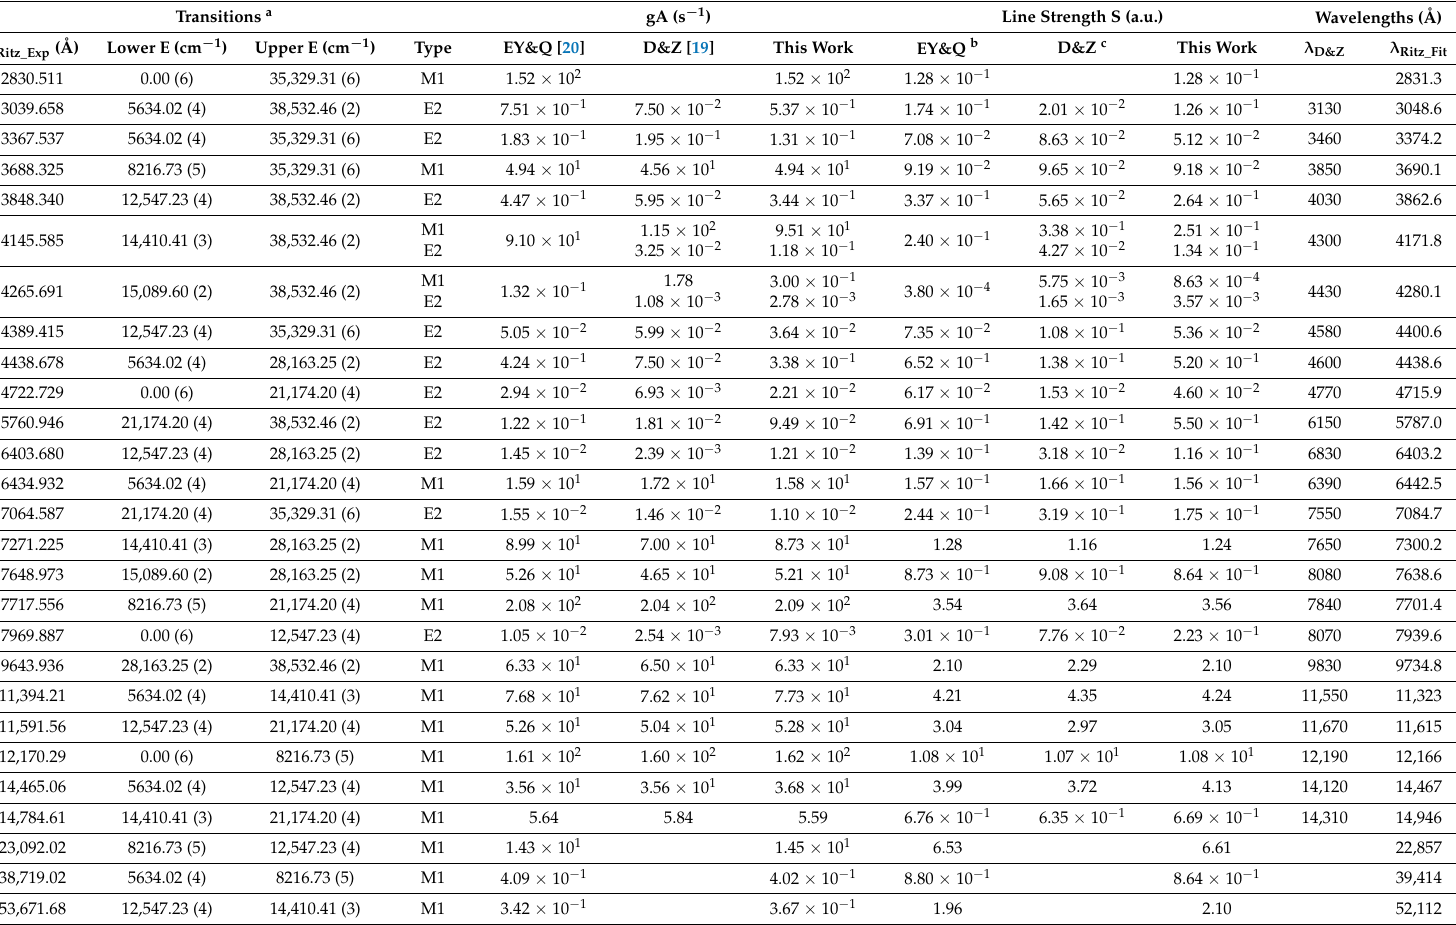
Table 2. Transition probabilities gA (s − 1 ) and line strengths for magnetic dipole (M1) and electric quadrupole (E2) transitions within the Tm IV ground-state configuration 4f 12 . Comparison with existing results. All wavelengths are in